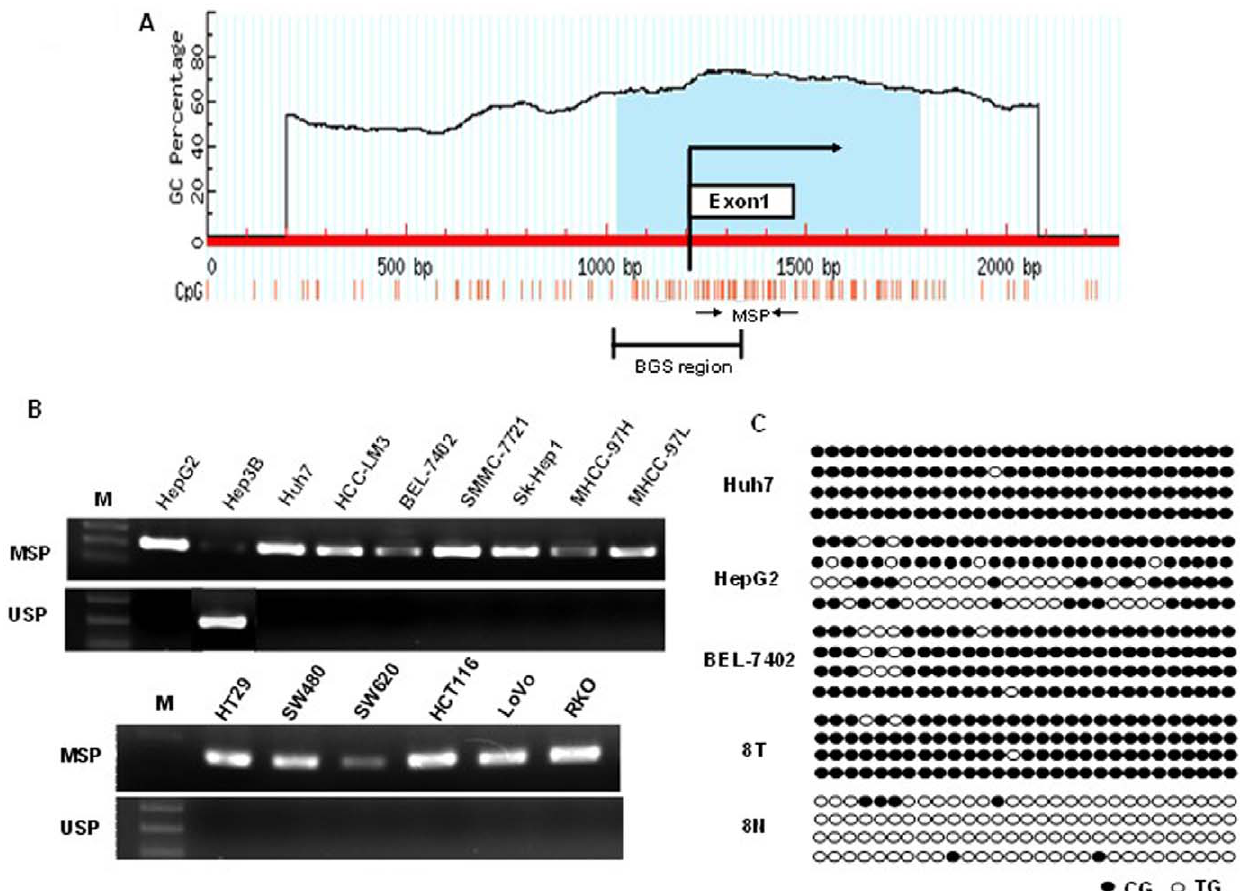
Figure 2. Methylation of FBP1 promoter in human liver and colon cancer. ( A ) Schematic structure of the FBP1 CGI, with the exon 1 and MSP and BGS region indicated. Each short vertical line represents one CpG site. The position of MSP primers were marked as arrows. The methylation status of the FBP1 CGI was analyzed by MSP ( B ) and BGS ( C ). MSP=Methylation-specific PCR; USP=Unmethylation-specific PCR. For BGS in ( C ), each circle indicates one CpG site and circles filled in black represent methylated CpG sites. One row of circles represents a single